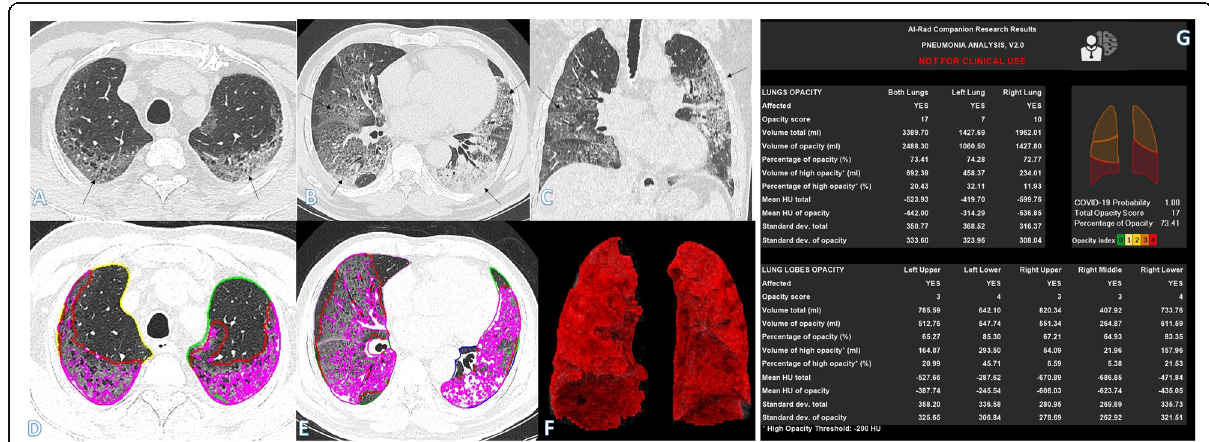
Fig. 2 A 64-year-old male with positive COVID-19 virus. CT chest shows centrilobular emphysematous changes with bilateral diffuse ground-glass opacities with crazy-paving appearance with more involvement of both lower lobes (arrows in a – c ). Total severity score = 17. Quantitative analysis by AI-Rad Companion Research CT Pneumonia Analysis was presented ( d – g ) with the measured parameters seen in table ( g ). Quantitative total opacity score was